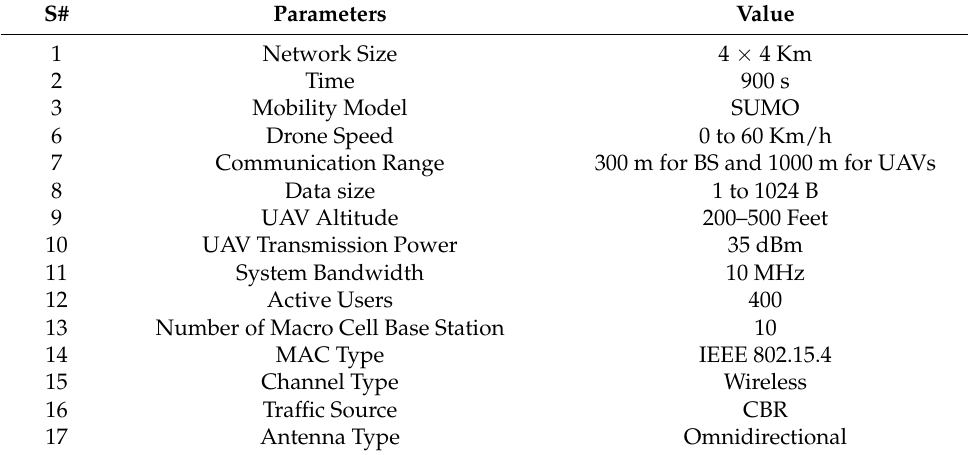
Table 1. Simulation